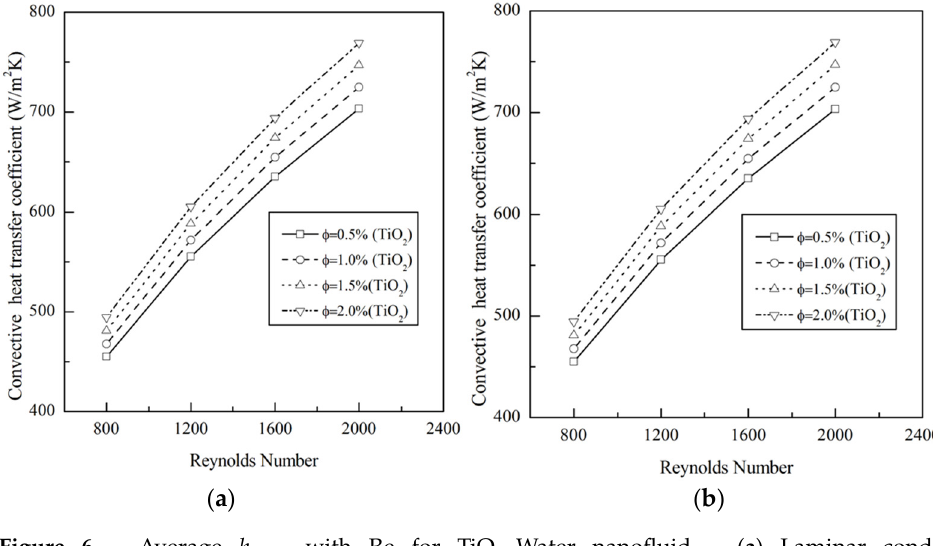
Figure 6. Average h conv with Re for TiO 2 –Water nanofluid. ( a ) Laminar condition. ( b ) Turbulent condition.